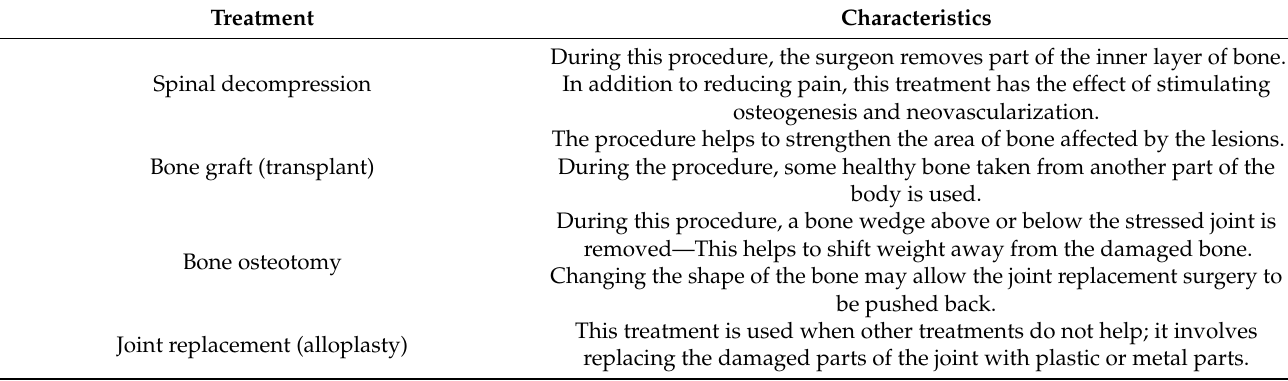
Table 3. Surgical procedures used to treat AVN